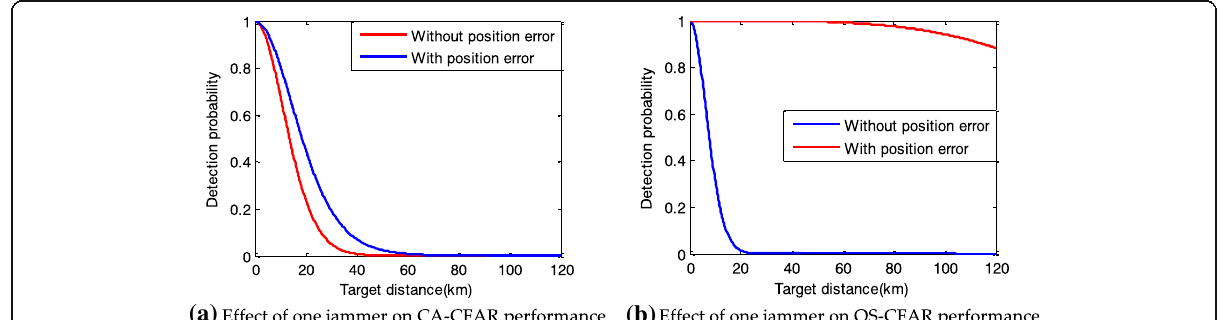
Fig. 10 Effect of one jammer on the detector ’ s performance with/without position error. a Effect of one jammer on CA-CFAR performance. b Effect of one jammer on OS-CFAR